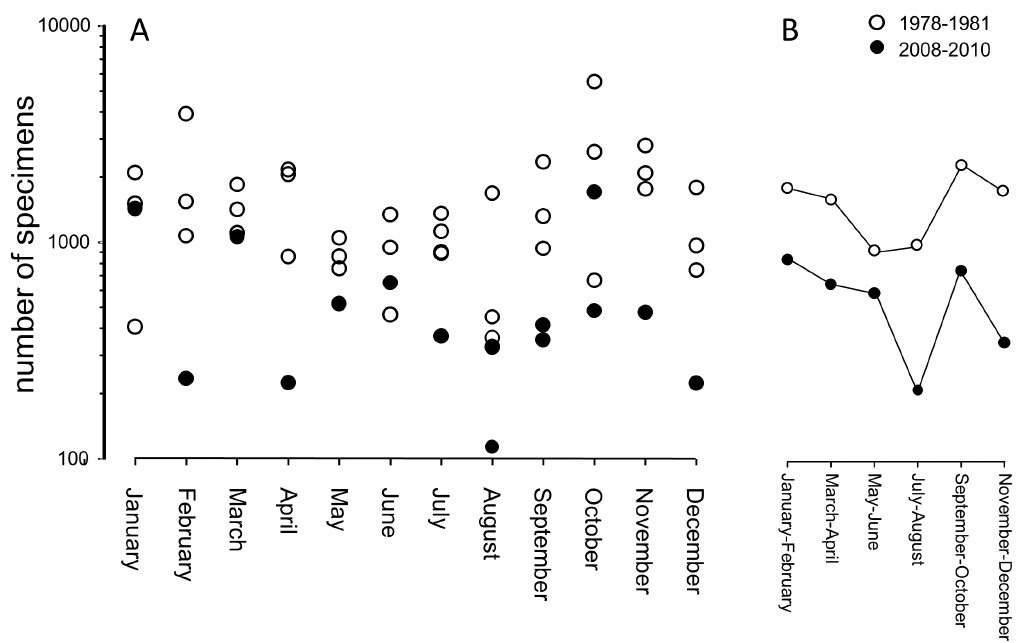
Figure 3. Seasonal changes in abundance of common bivalve species based on transects conducted along the shoreline of the Llarga Beach. (a) A bivariate log-linear plot of monthly changes in abundance of common bivalve species based on transects conducted along the shoreline of the Llarga Beach during 1978–1981 and 2008–2010 sampling intervals. Each point represents a single monthly transect; (b) A comparison of bimonthly changes in average abundance for 1978–1981 versus 2008–2010 sampling